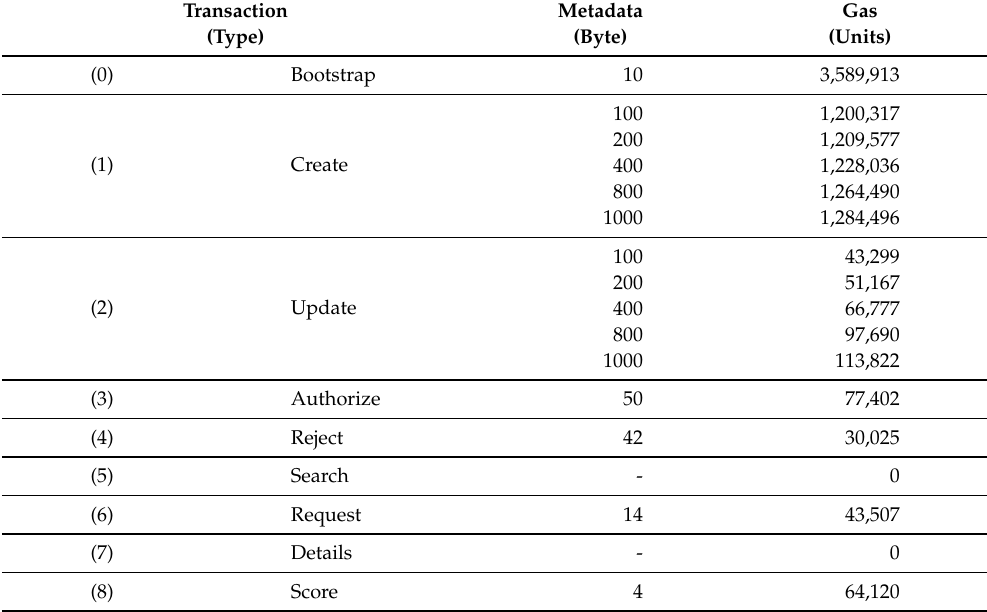
Table 4. Transaction cost (gas usage) using different size of metadata.